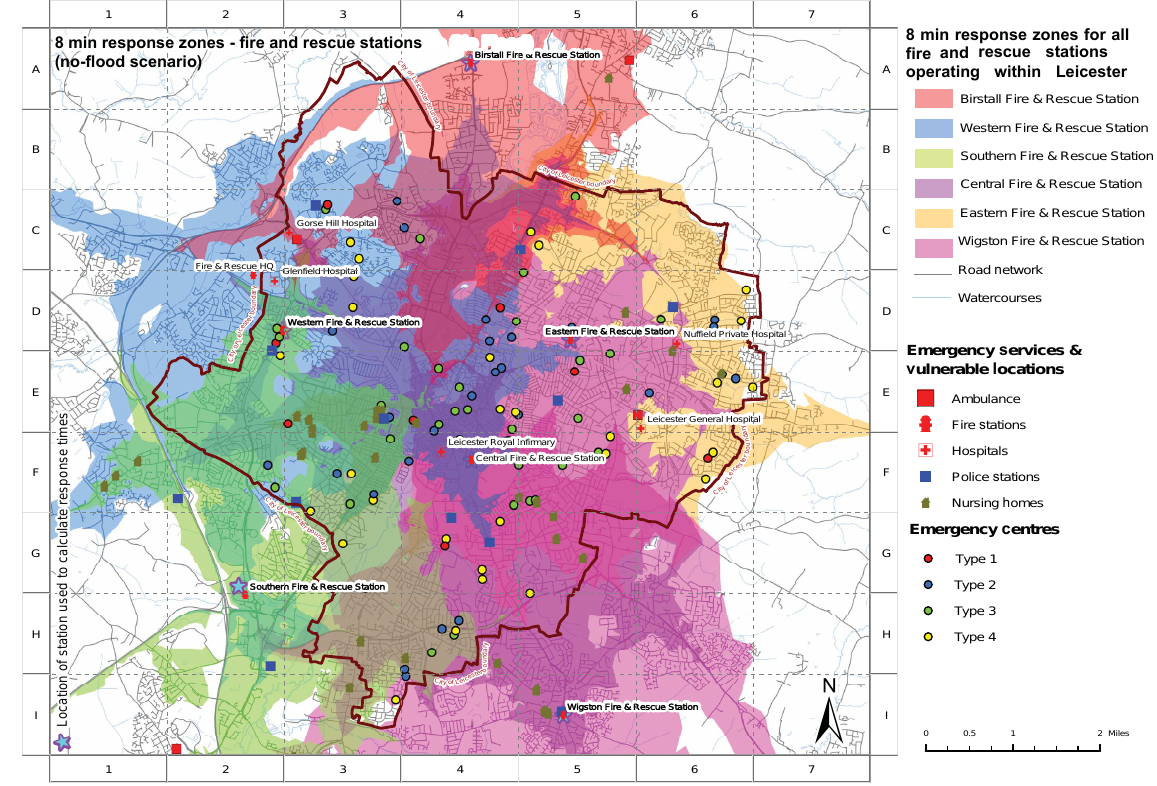
Figure 6. City accessibility (within 10min) for fire and rescue service stations under normal no-flood